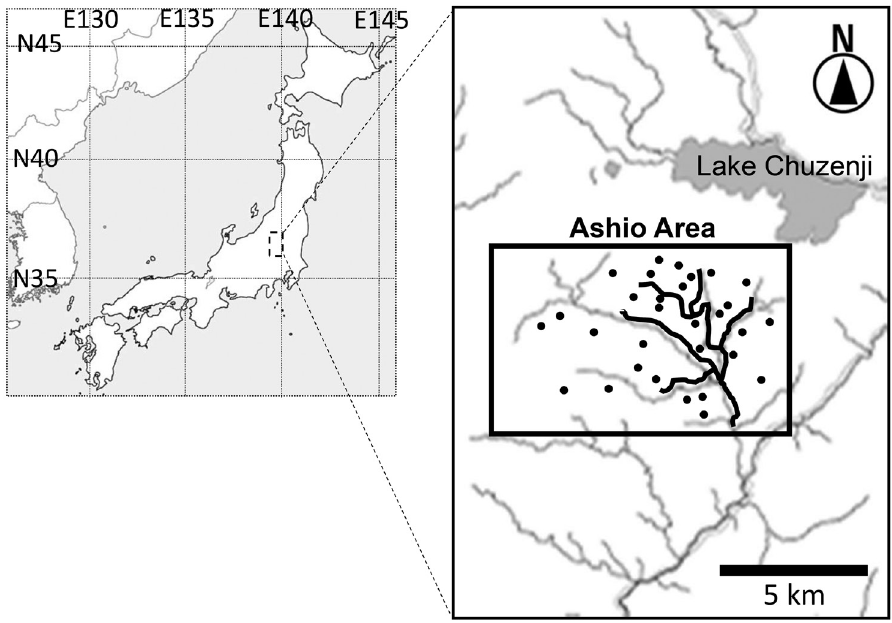
Figure 1. Map of the study area, located in the Ashio-Nikko Mountains range in Tochigi and Gunma Prefectures, central Japan. Black lines were trails to observe bears and black circles were the points of veg- etation surveyed in the Ashio